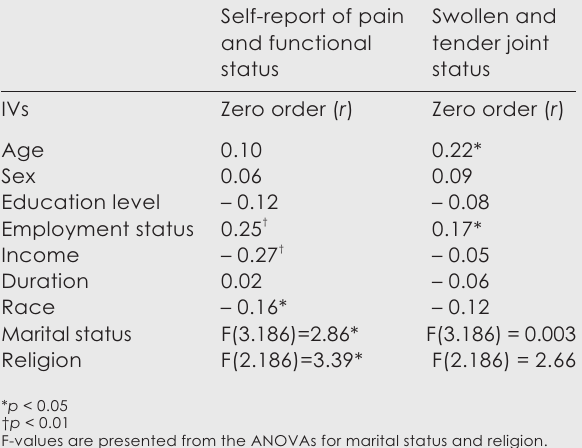
Table II. Pearson’s product-moment correlation coefficients (zero order r ) between independent and dependent vari- ables and marital status and religion are represented using F-values from analysis of variance (ANOVA)